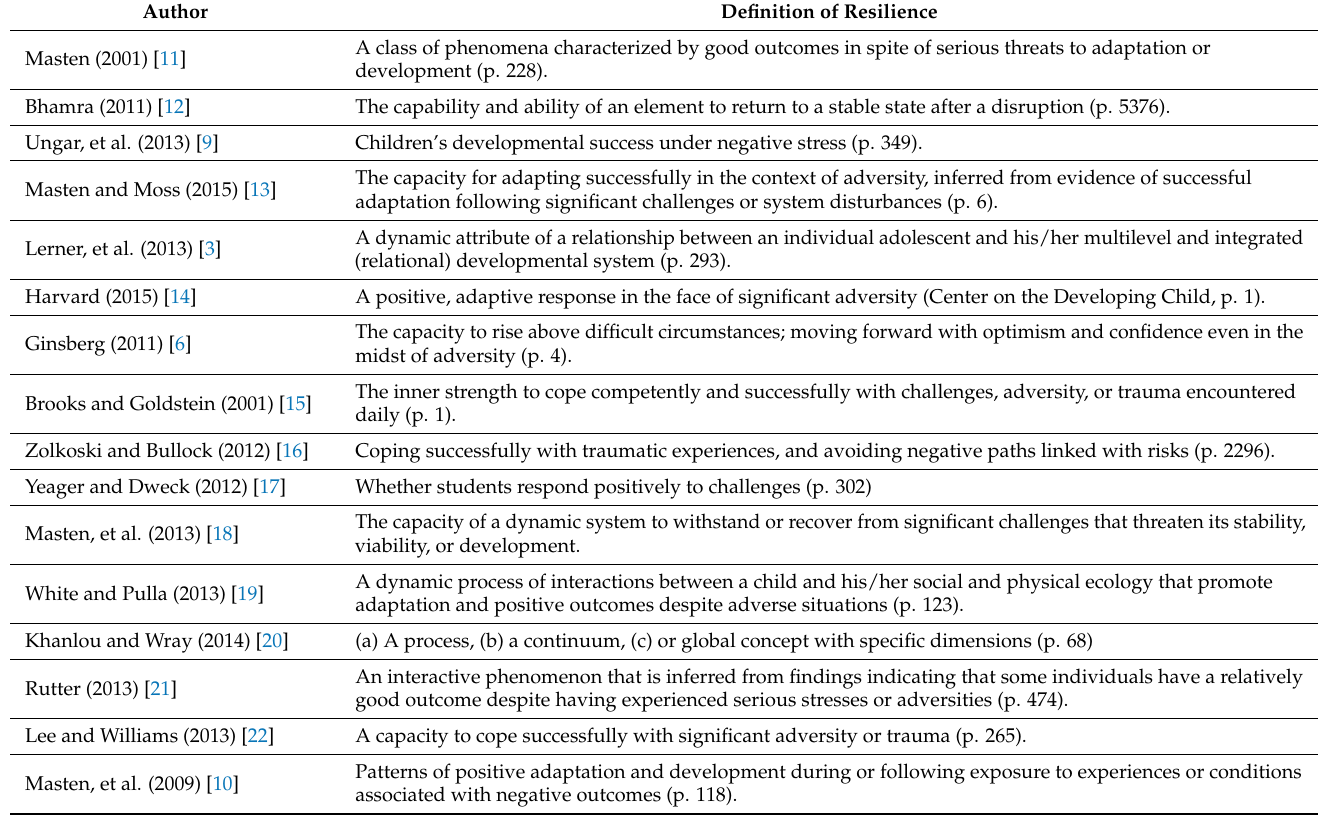
Table 1. Definitions of resilience in the